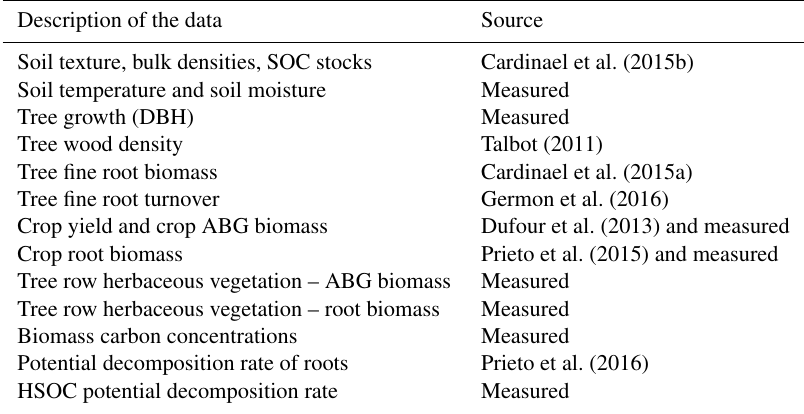
Table 1. Synthesis of the different field and laboratory data available or measured and their sources.